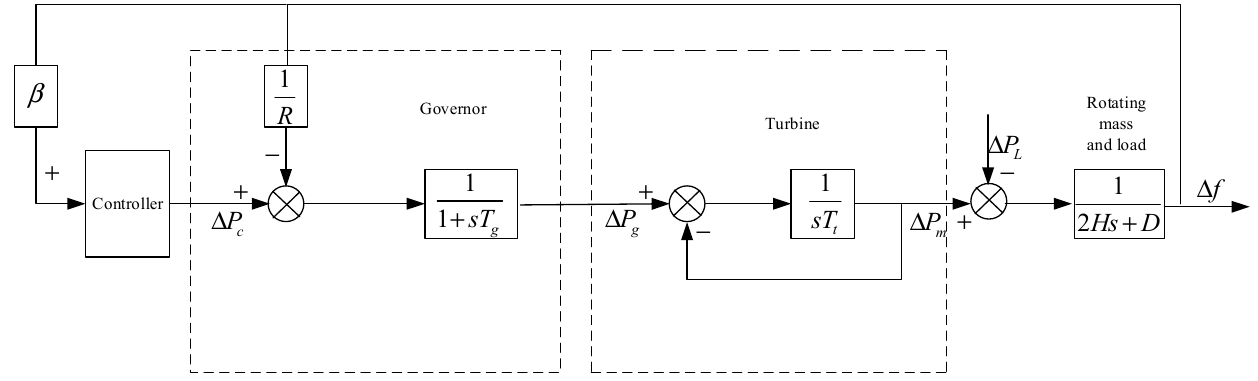
Figure 2. Dynamic model of the power system. Table 1. Parameters of the power system.